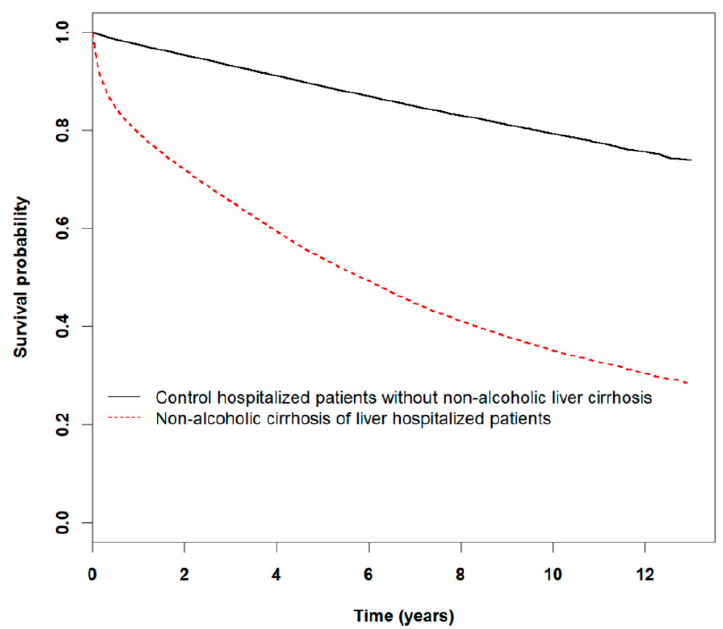
Figure 3. Kaplan-Meier curves for all-cause mortality for study and control cohorts.